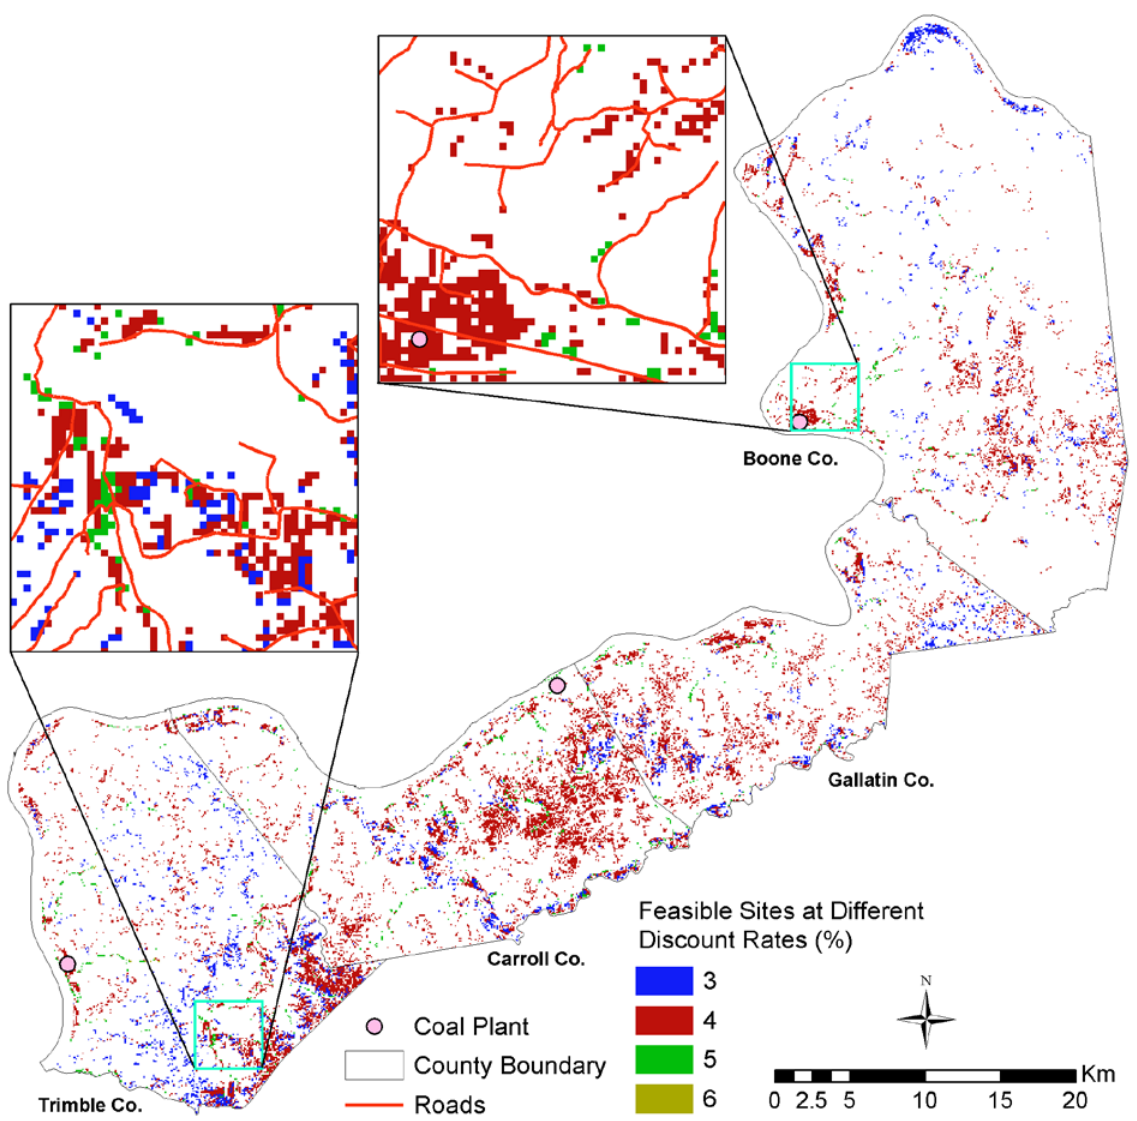
Figure 4. Spatial distribution of economically feasible sites for establishing sweetgum at different discount